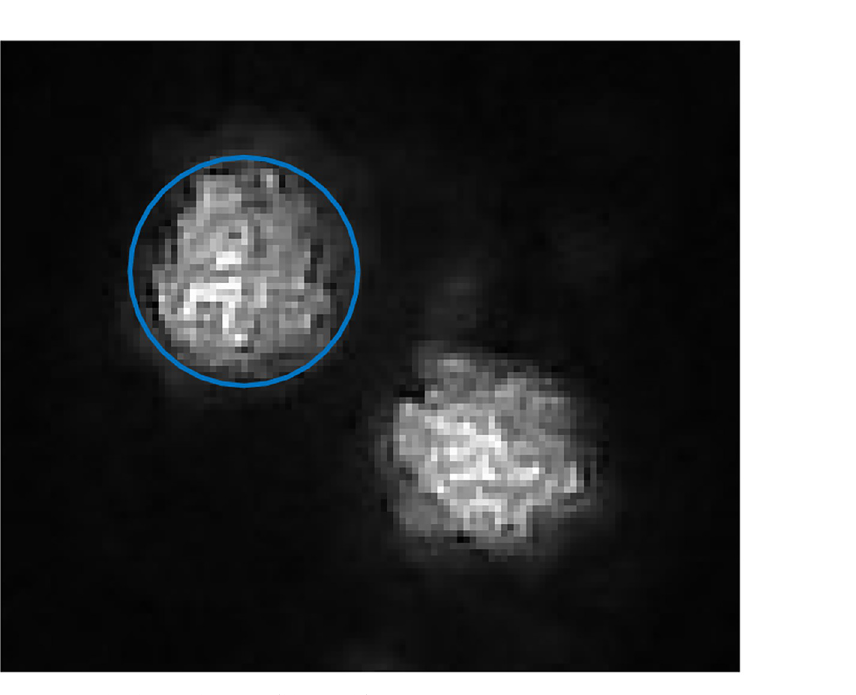
Fig 5. Example of waist detection (blue